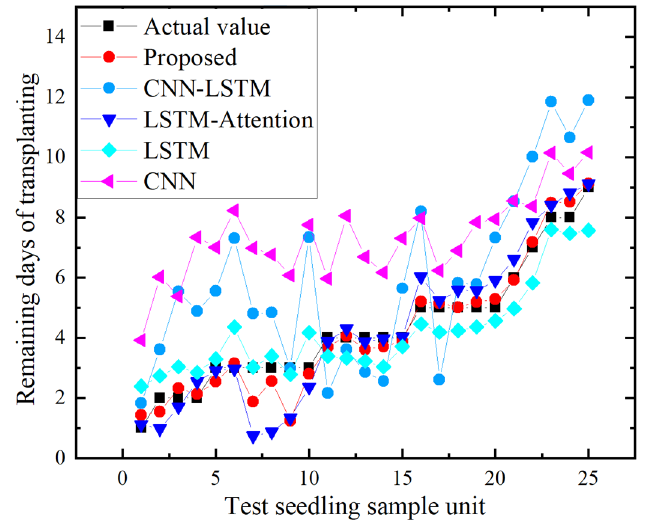
Figure 8. Comparison of the prediction results of different models. The horizontal axis represents the seedling sample unit of the test set, and the vertical axis represents the remaining transplanting time. The black rectangles represent the actual value, the red circles represent the predicted value of the model proposed in this paper, the blue circles represent the expected value of CNN-LSTM, the purple inverted triangles represent the predicted value of LSTM-Attention, the cyan diamonds represent the expected value of LSTM, and the dark pink triangles represent the predicted values of the CNN.